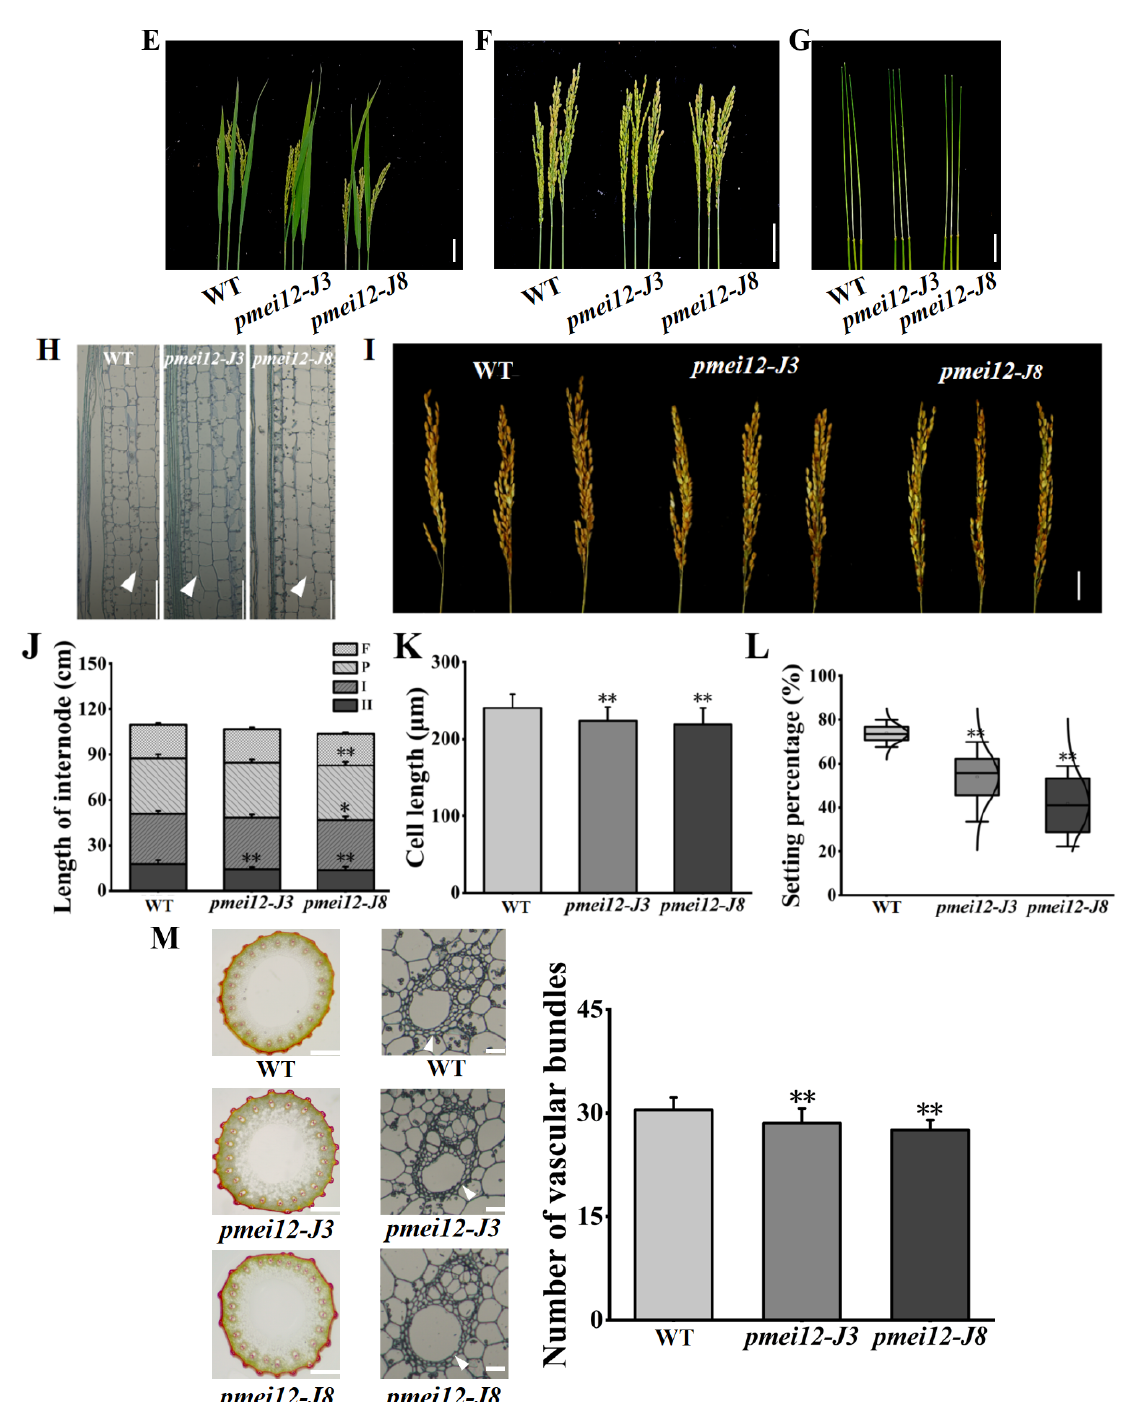
Figure 4. Agronomic traits and vascular bundles of pmei12 lines and wild type (WT). ( A ) Mutant information; ( B – G , I ) Agronomic traits of pmei12s and WT; ( H ) Section of the second internode; ( J ) L of flag leaf, panicle, and internode of WT and pmei12 lines (F: flag leaf; P: panicle length; I: the first internode; II, the second internode); ( K ) Cell length of the second internode (µm); ( L ) Setting percentage (%). ( M ) Vascular bundles of pmei12 lines under compound microscope (500 µm, 100 µm) and triangles indicated the vascular bundle sheath. * and ** indicated the significant differences between pmei12 lines and WT by t -test at p < 0.05 and 0.01, respectively. Scale bars: ( B , D ) 10 cm; ( C , E – G , I ) 5 cm; ( H ) 100 µm (n = 30).